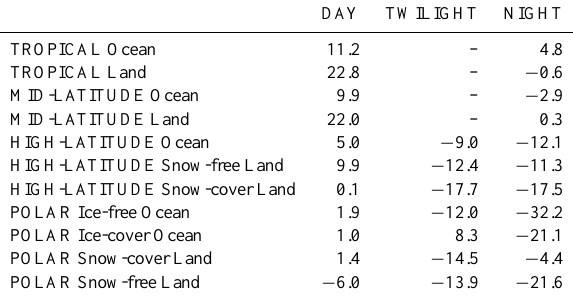
Table 4. Same as Table 3 but now after filtering results with cloud optical thickness threshold 0.35 (i.e. all CALIOP-detected clouds with smaller optical thickness are neglected and treated as a cloud- free